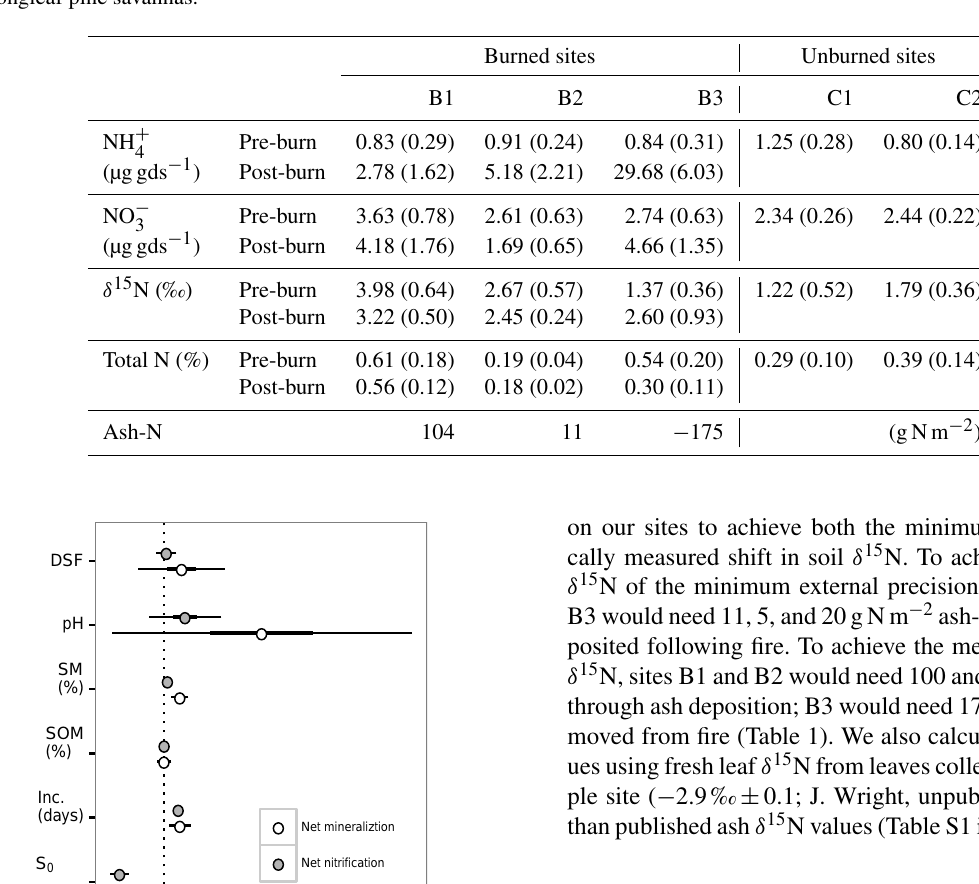
Table 1. Mean soil inorganic N pool sizes reported per gram of dry soil (gds), δ 15 N values, and total N for each study site. Values are reported ± 95%CI. Sample sizes for inorganic N pool sizes differ between sites depending on when the prescribed burns occurred; see Methods for details on sample sizes. Soil %N and δ 15 N values were collected on a subset of time points; sample sizes for these variables are N = 6 for burned site means, and N = 12 for control (unburned) site means. Ash-derived N values are the estimated masses of N needed to be deposited onto each site to result in the observed post-burn δ 15 N. Note that Christensen (1977) measured 1.15 ± 0.49gNm − 2 deposited in ash fall in fire in a longleaf pine savannas.